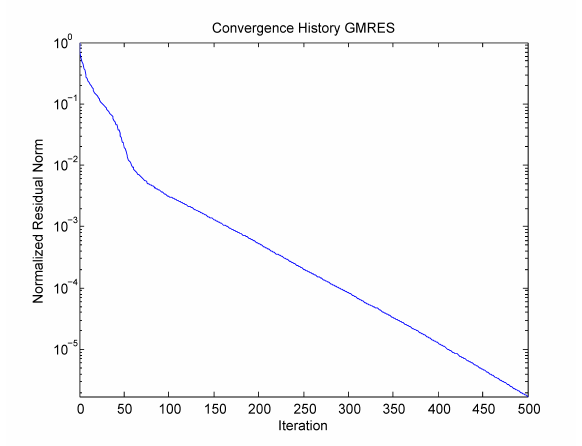
Figure 4: Convergence history of GMRES for the golden strip problem.